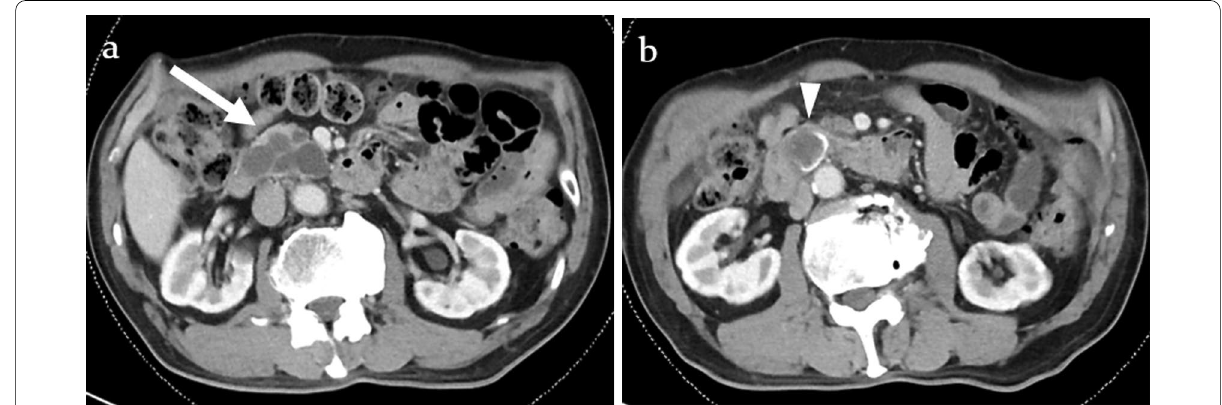
Fig. 1 a Enhanced abdominal computed tomography (CT) revealed a 58 mm multilobular cystic lesion with a 17 mm mural nodule (white arrow) in the pancreatic head. b Prominent calcification was observed on part of the cyst wall (white